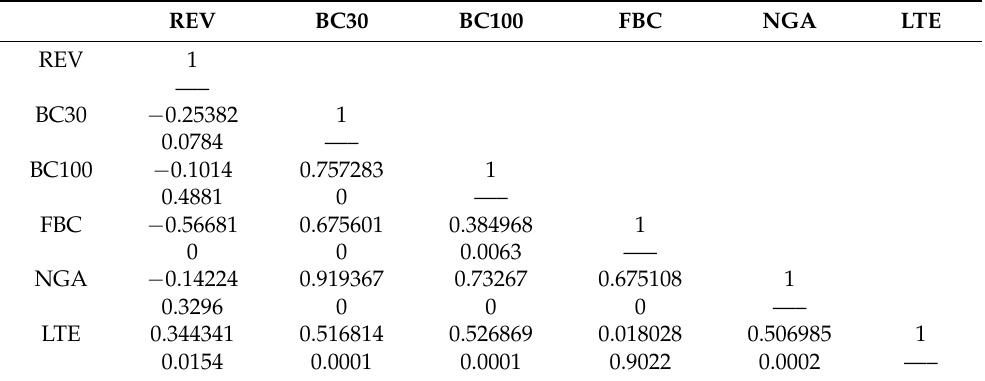
Table 5. Correlation matrix.